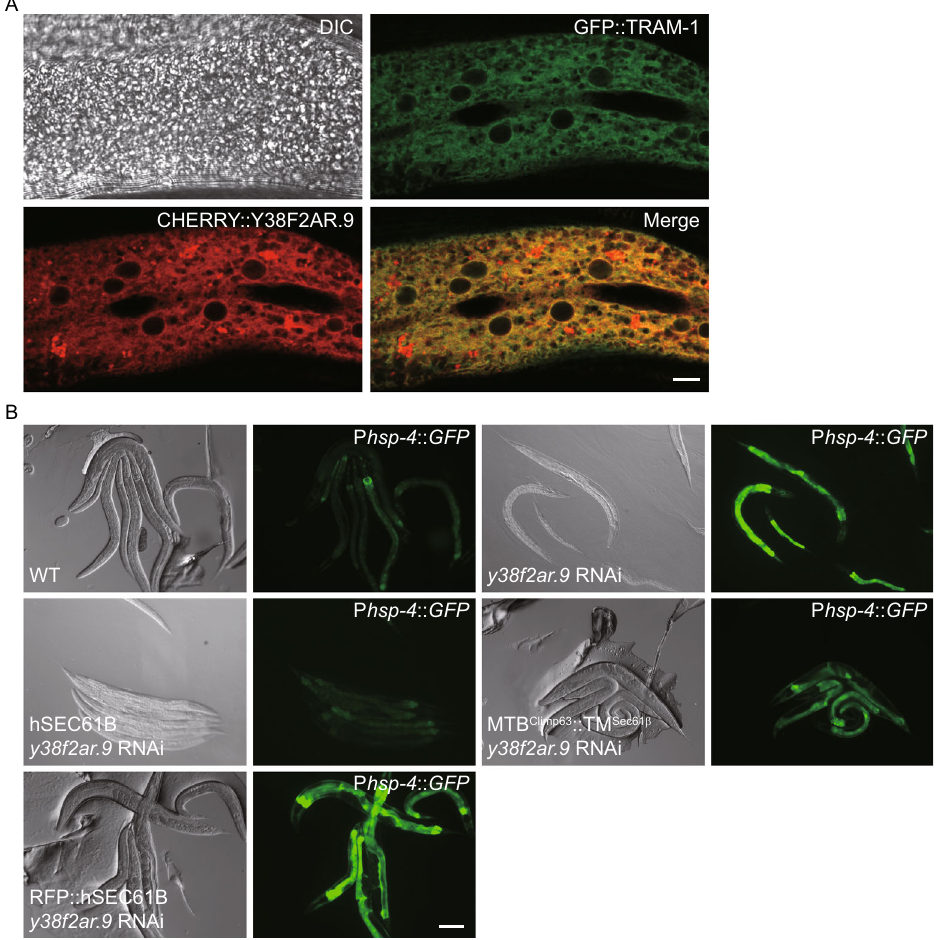
Figure 5. The function of Sec61 β is essential and conserved in C . elegans . (A) Fluorescent micrographs of hypodermal cells in gfp :: tram-1 worms expressing CHERRY::Y38F2AR.9. DIC, differential interference contrast. Scale bar: 5 μ m. (B) The y38f2ar . 9 RNAi was injected into worms carrying P hsp-4 :: GFP , and GFP fl uorescence was assessed. For rescue assay, y38f2ar . 9 RNAi was injected into P hsp-4 :: GFP ER stress reporter worms carrying human SEC61B, MTB Climp63 -TM Sec61 β or RFP-hSEC61B, and GFP fl uorescence was assessed. Scale bar: 100